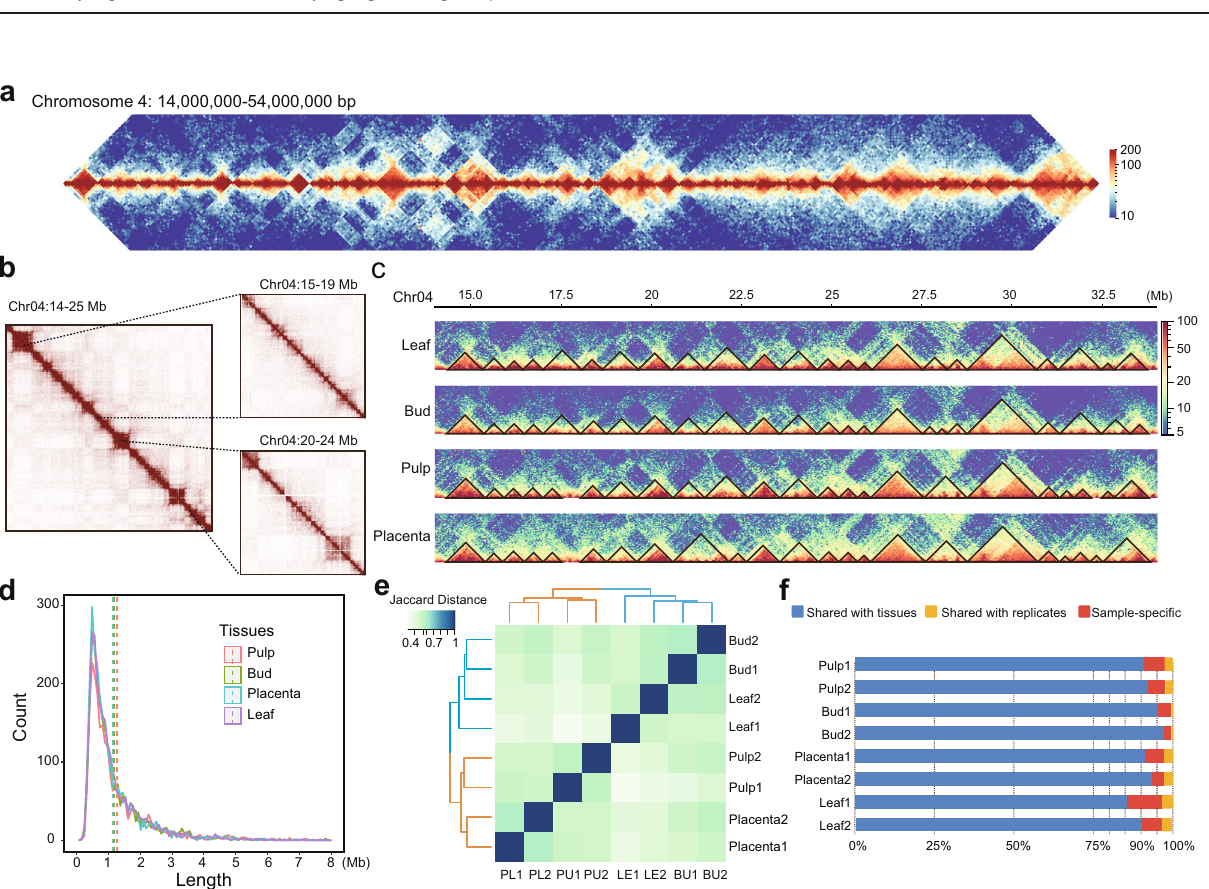
Fig. 2 Subcompartments are correlated with a number of genomic and epigenomic landscapes and maintained across tissues in the pepper genome. a Pearson correlation matrix heatmap (leaf 500-kb) shows the segregation of the pepper genome into global A/B compartments. The fi rst principal component (PC1) derived from the analysis of this matrix was used to de fi ne the A and B compartments and is displayed below. Positive PC1 values are shown in red, representing A compartments, and negative PC1 values are shown in blue and designated as B compartments. b The size distribution of the Calder -inferred subcompartments using 10-kb resolution matrices across tissues. All samples display a roughly constant size distribution with a mean value of ~250kb. c The genome-wide percentage of subcompartments called across tissues. Most (59 – 65%) of the genome is classi fi ed as inactive B subcompartments. d Enrichment analysis of genomic and epigenomic features (rows) across subcompartments (columns). Log2 fold changes between the observed median value and the expected median values are color-coded. Enrichment values were calculated based on Hi-C maps of 10-kb bin size. e Correspondence of subcompartments and the distribution of genomic (gene and LTR content) and epigenomic features (DNA methylation and histone modi fi cations) shown for chromosome 1. Only DNA methylation level sum across all cytosine residues is shown. The tracks for individual tissues mark regions of A (red) or B (blue) compartments. A local example is shown below. f Similarity of the A/B compartments and subcompartments between tissues. The upper part of the matrix is shown for 8 subcompartments, while the lower part is shown for A/B compartments. g Subcompartment switching between tissues. Pairwise comparisons across four tissues were shown. Numbers above where “ 0 ” indicates unchanged subcompartment, “ 1 ” , “ 2 ” , and “